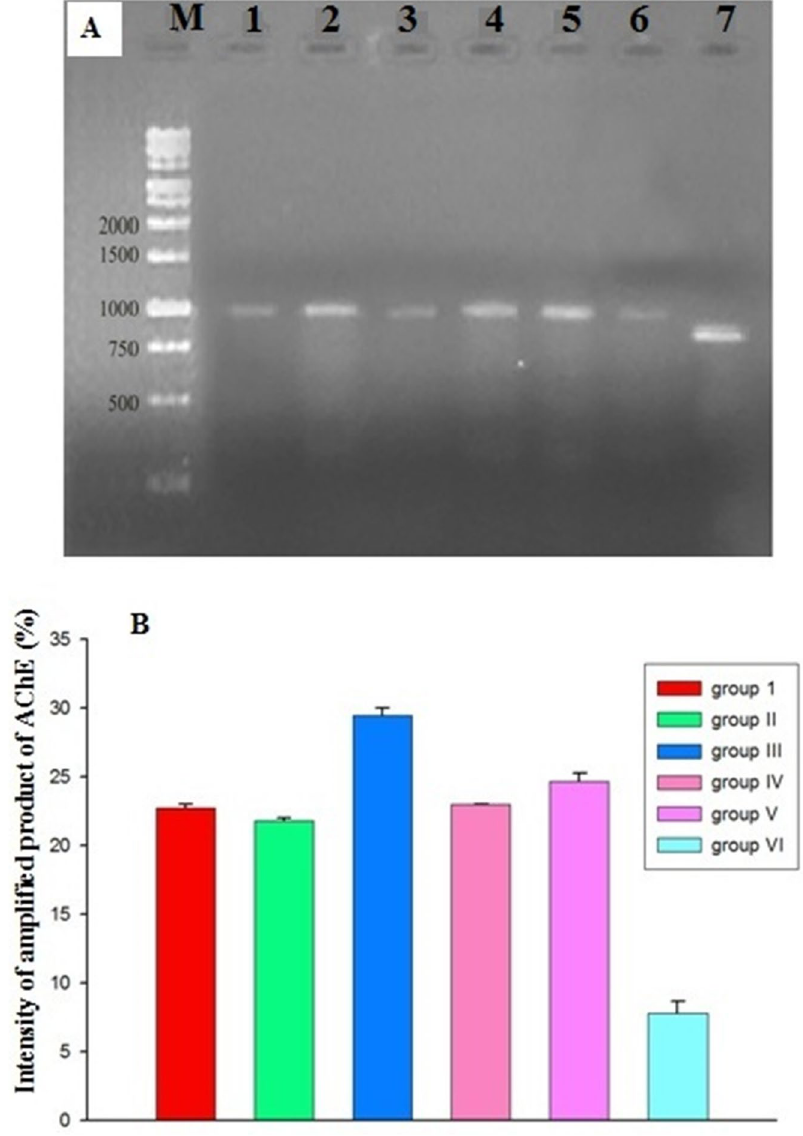
Figure 4. A,B Products of expression of site specific amplification of AChE gene with primer 1 and change in their intensity pattern in different groups. M—marker, Lane 1—group I, Lane 2—group II, Lane 3—group III, Lane 4—group IV, Lane 5—group V, Lane 6—group VI, Lane